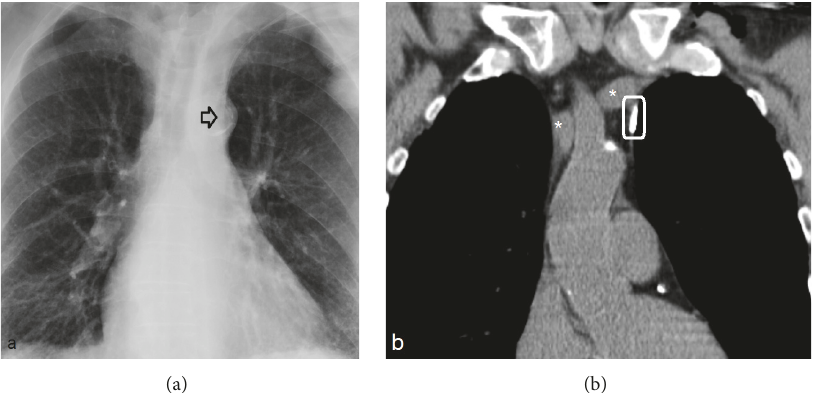
Figure 1: (a) The a.p. chest X-ray shows the catheter tip (black arrow) at the left margin of the mediastinum. (b) depicts a CT of the thorax. The catheter tip is marked in white. ∗ left brachiocephalic vein.